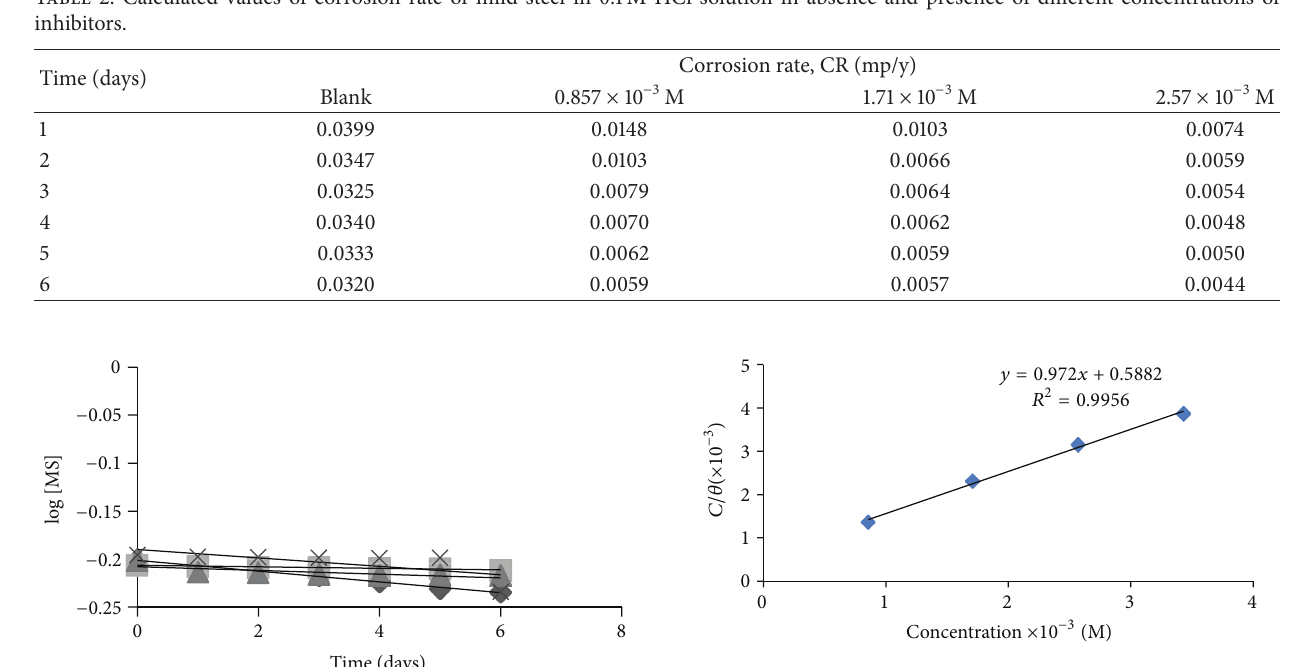
Figure 4: Langmuir’s adsorption isotherm for mild steel in 0.1M HCl containing various concentrations of ciprofloxacin as